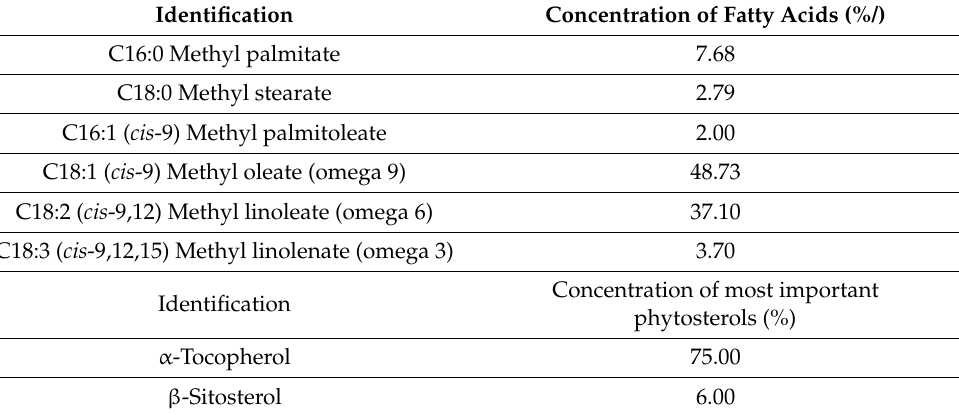
Table 2. Bioactive compounds present in Pazze avocado